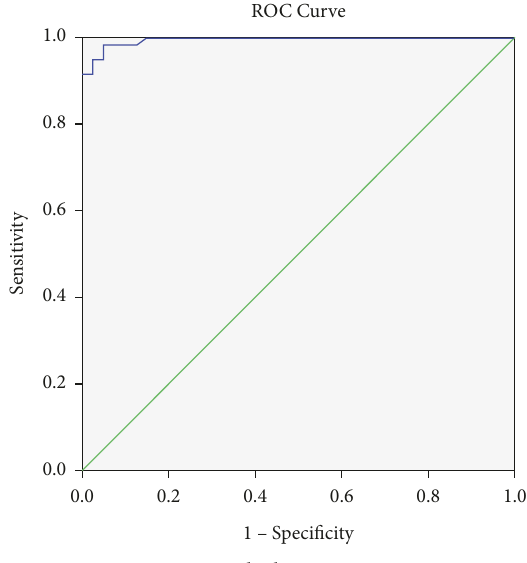
Figure 3: ROC leukocyte parameter.